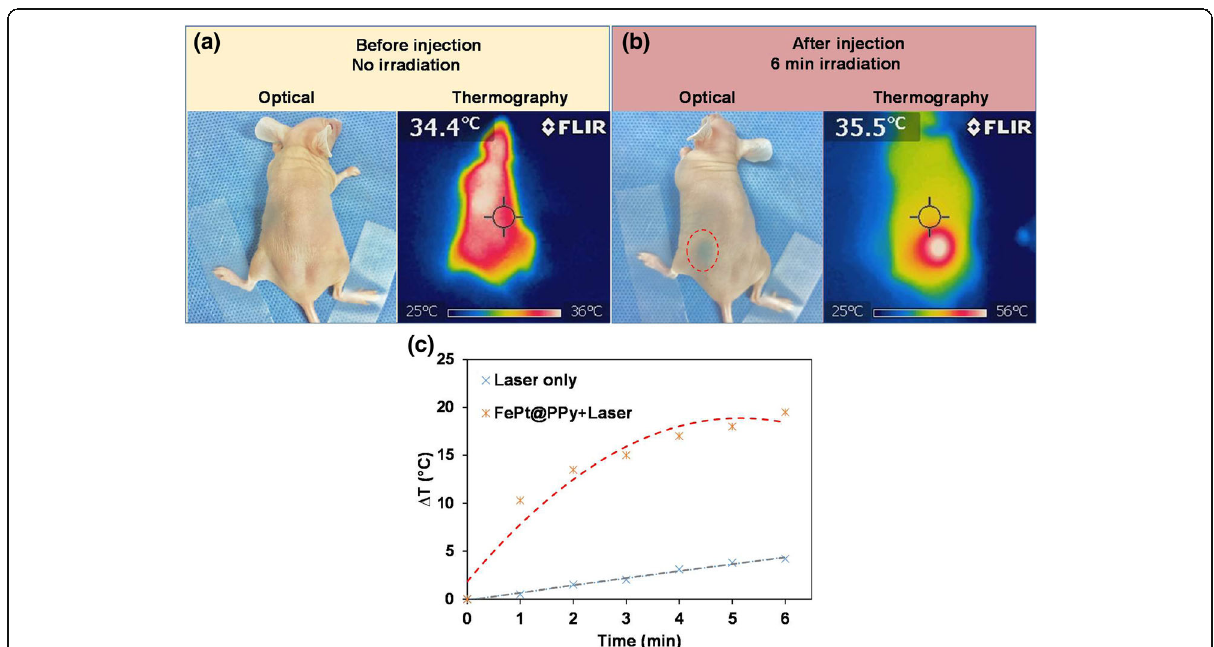
Fig. 10 a The optical image and the corresponding NIR thermographic images of the nude mouse before injection of FePt@PPy NPs. b The left side: the optical image of the nude mouse with subcutaneous injection. The dashed red circle indicates the location of the injection. The right side: the NIR thermographic image of the nude mouse after 6 min under irradiation at an 808-nm laser (1 W/cm 2 ). Note that the maximum heating corresponds to the injection site. c Temperature change of the skin ’ s surface at the injection site and in the mice with irradiation at the 808-nm laser (1 W/cm 2 ) for 6